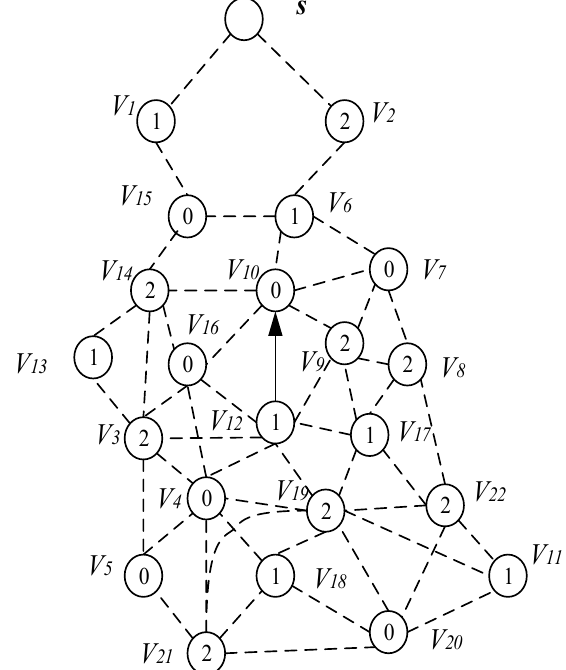
Figure 21. Physical link for ABRCD.